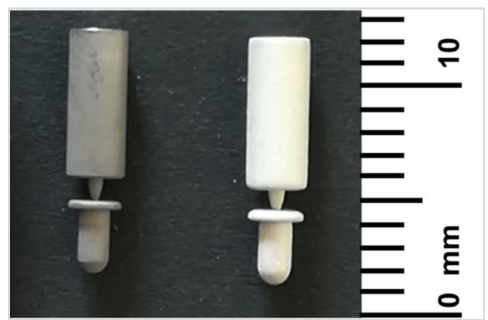
Figure 1. Customized uncoated ( left ) and sphene-coated ( right )